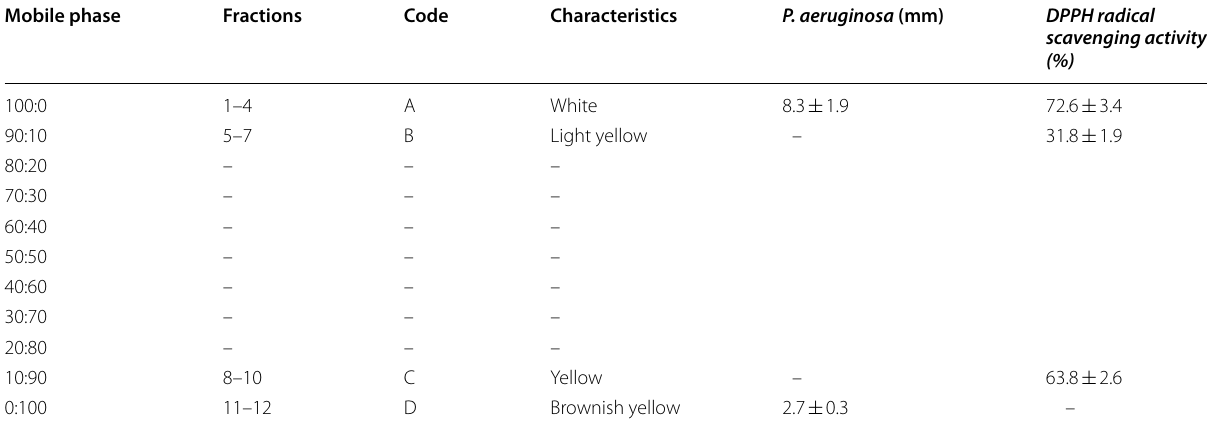
Table 3 Fractions of S. maritima eluted using mobile phase (Hexane:Chloroform) at different gradients and their antibacterial and antioxidant activities Mobile phase